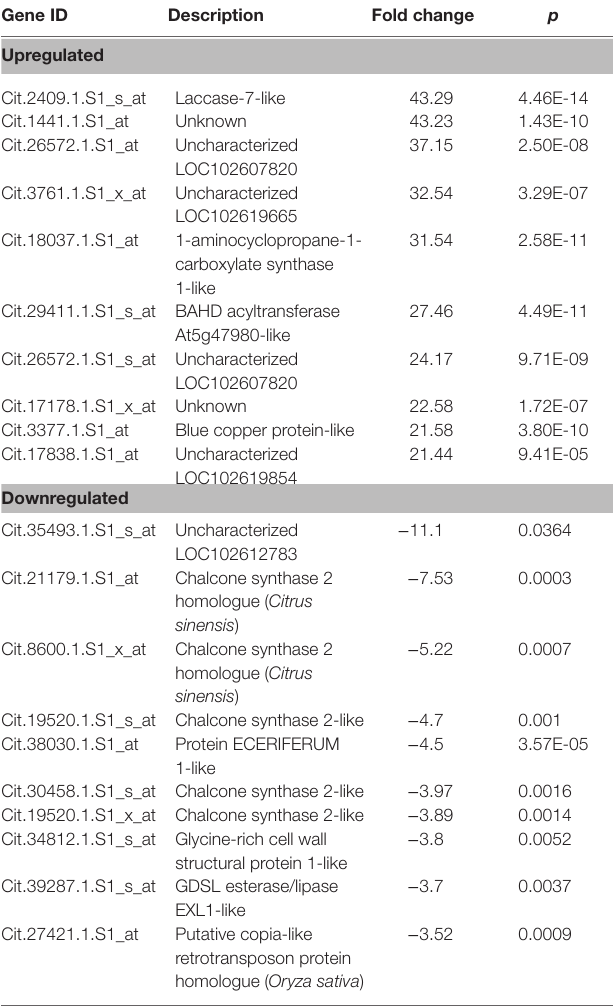
TABLE 5 | A sample of the differentially expressed genes in the infected vs. MFA + infected